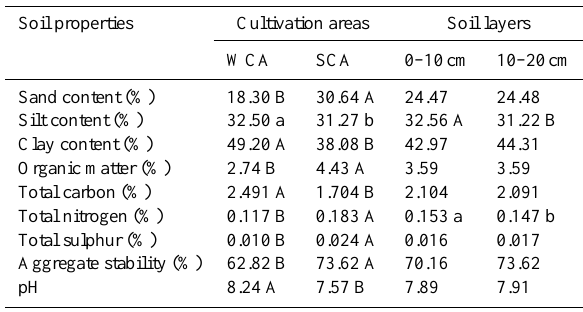
Means with capital and small letters indicate significant differences; 0.01 and 0.05, respectively. (WCA: wheat cultivation area; SCA: safflower cultivation